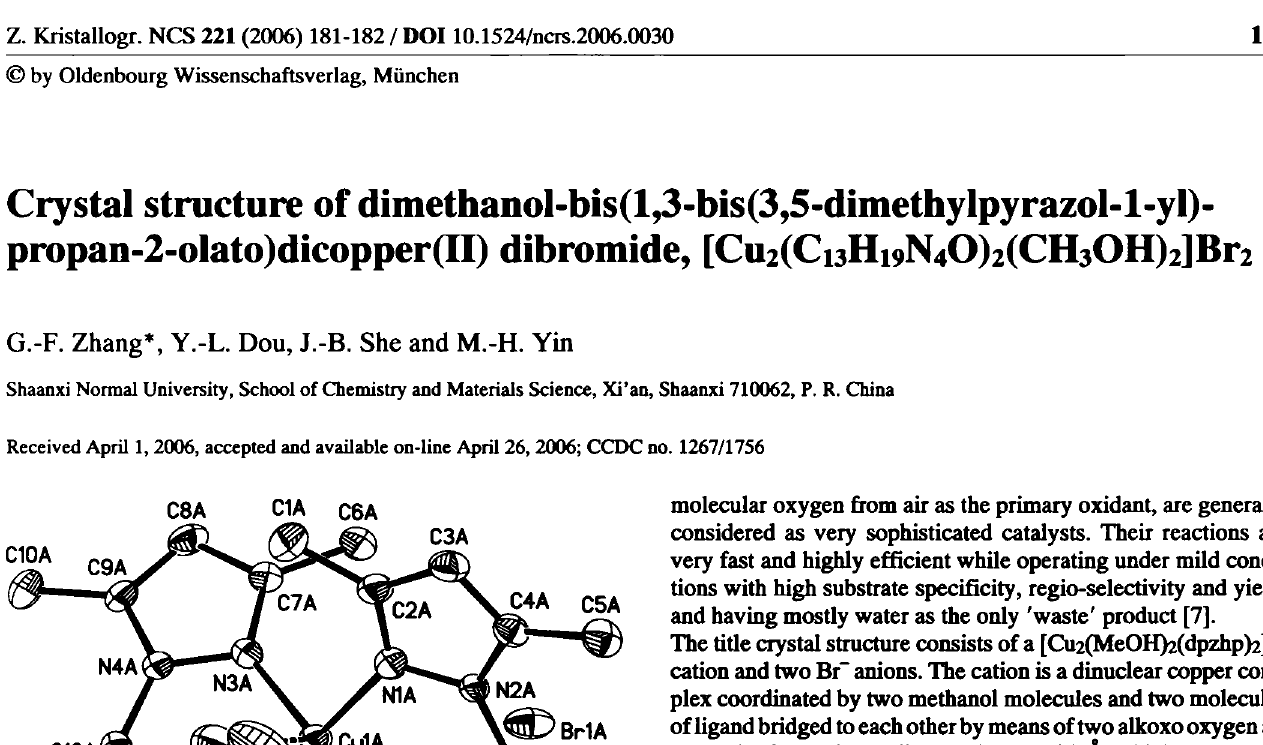
Table 1. Data collection and handling.